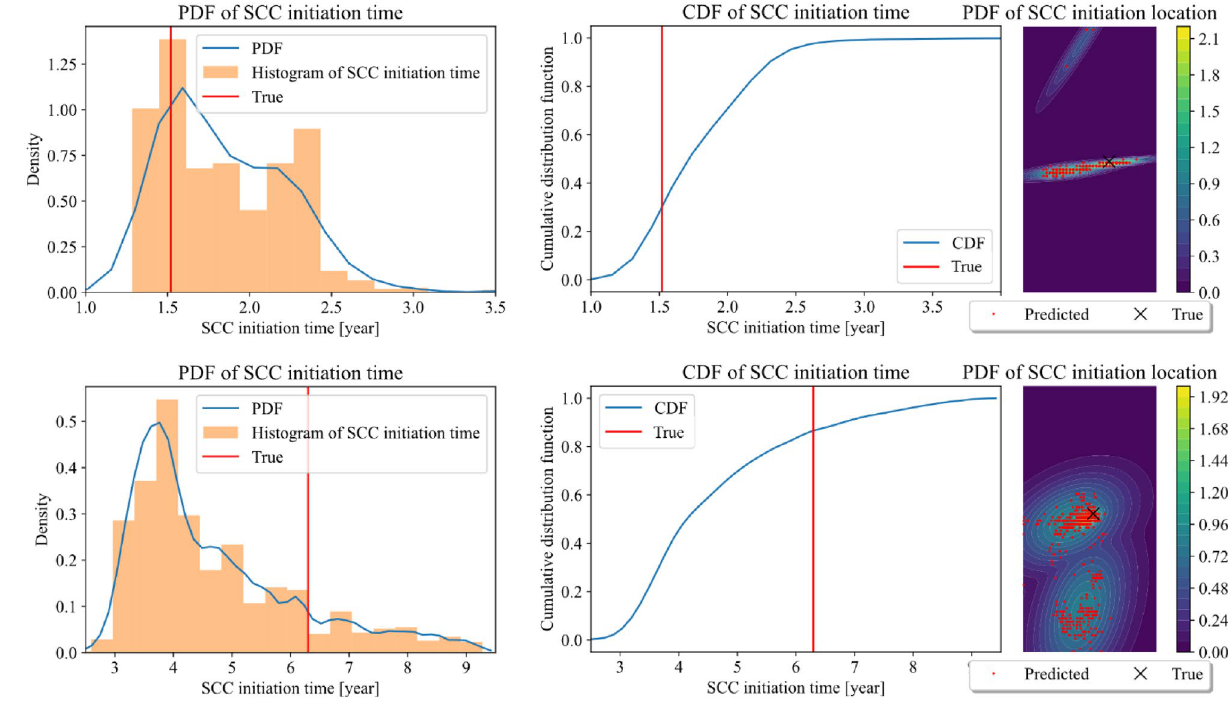
Figure 20. SCC initiation time and location distribution for case (b) given in Fig. 17 and case (c) given in Fig.